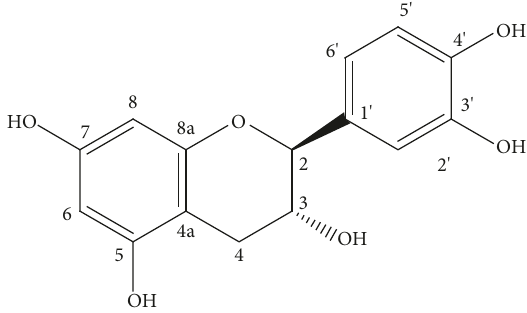
Figure 1: Chemical structure of ( − )